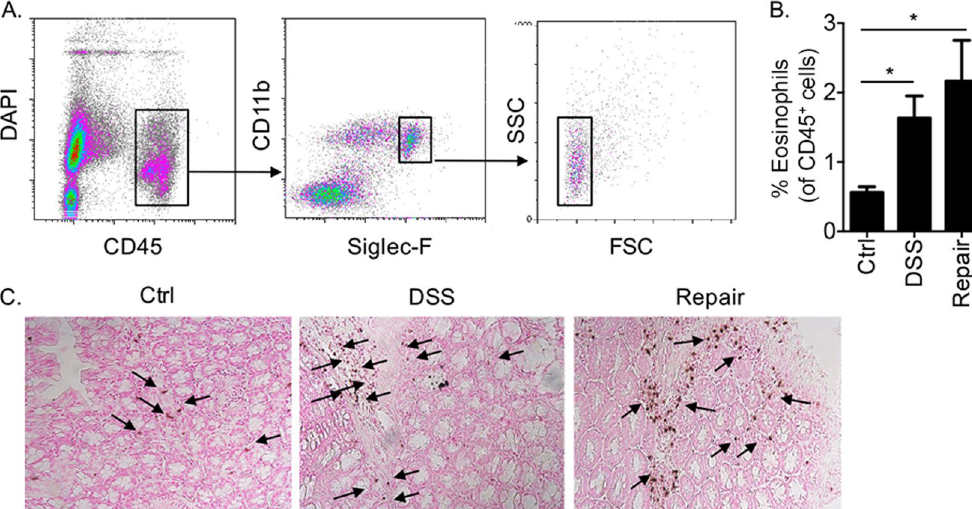
Figure 1. Eosinophils are present in the colon during mucosal healing. Gating strategy for identification of colonic eosinophils in the lamina propria following enzymatic digestion ( A ). The percent of eosinophils during colonic inflammation (DSS) and Repair ( B ) as well as representative photomicrographs of H&E-stained slides from control (Ctrl) mice and mice in the inflammation and repair stages ( C ). Data in ( A ) and ( C ) are representative of at least n = 3; Data in B are from at least n = 10 mice, * p <